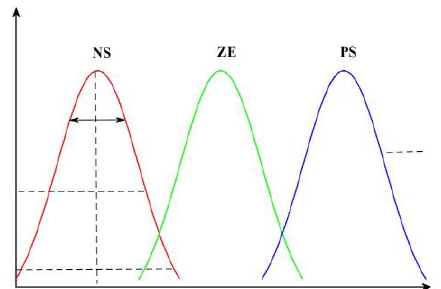
e k and ( ) e k  ) . i i e k and i